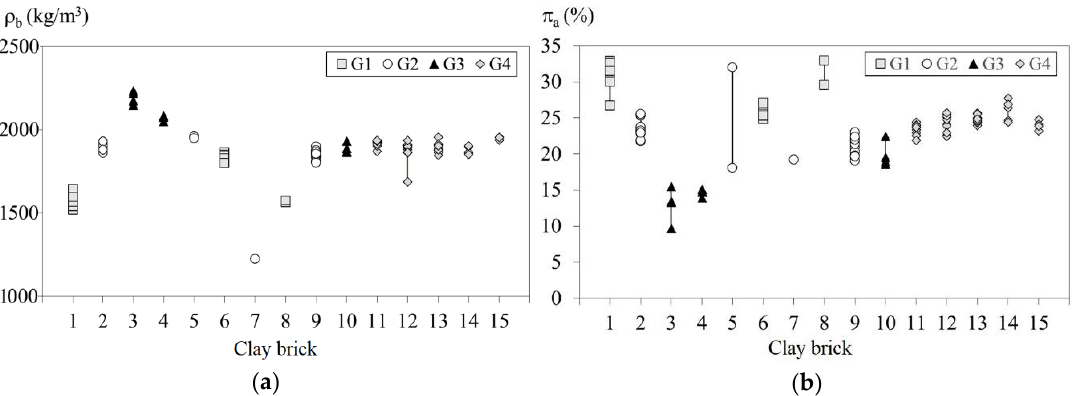
Figure 4. Results grouped by clay bricks: ( a ) dry density; ( b ) open porosity.